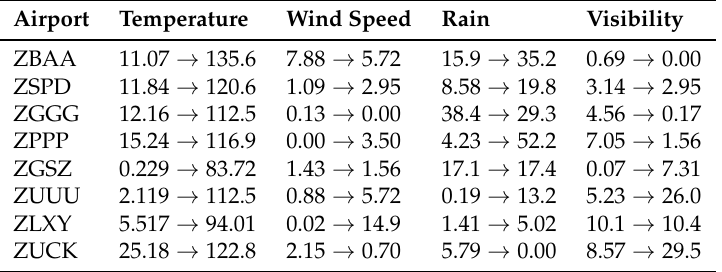
Figure 5. Box-plots of the distributions of the average daily delays, for days without (left) and with (right) thunderstorms near or at the airport. The p -values of Welch’s two-sample t -tests, assessing the equality of both distributions, are reported in the upper part of each panel. Table 4. Evolution of the weather-delay relationships. Each cell reports the evolution of the χ 2 statistics of a test assessing the presence of a relationship between high delays and a meteorological factor, for a given pair airport-metric, from the first year of the data set (May 2016 to April 2017, left side of the arrow) to the second year (May 2017 to April 2018, right side of the